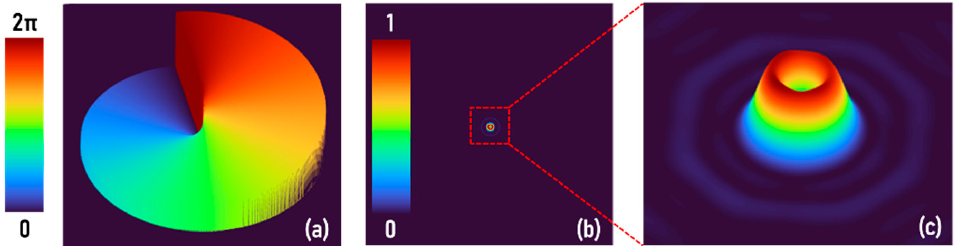
Figure 2. ( a ) Phase profile of a spiral phase plate with topological charge L = 1. ( b ) Far-field diffraction pattern and ( c ) its magnified profile.